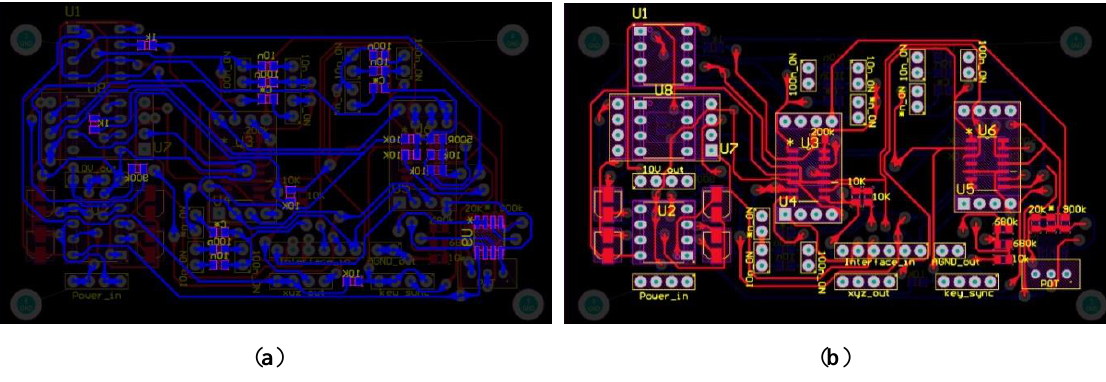
Figure A2. PCB design of analog chaotic system simulation circuit: ( a ) first layer and ( b ) second layer.